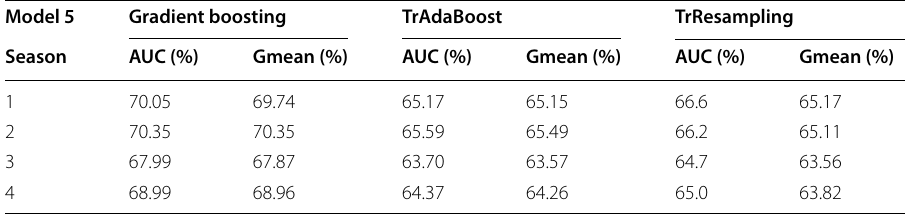
Table 8 AUC and Gmean scores based on Vancouver and Halifax data (model 5) Model 5